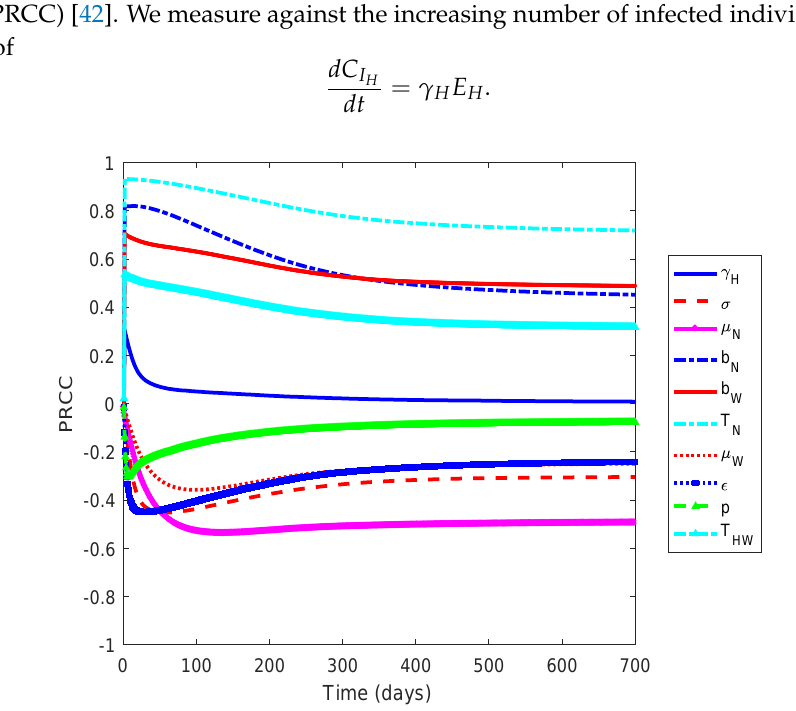
Figure 1. Partial Rank Correlation Coefficient (PRCC) values for the model when measured against the increasing number of infected individuals. The positive and negative values indicate the relationship of the parameter and an increase in the number of infected